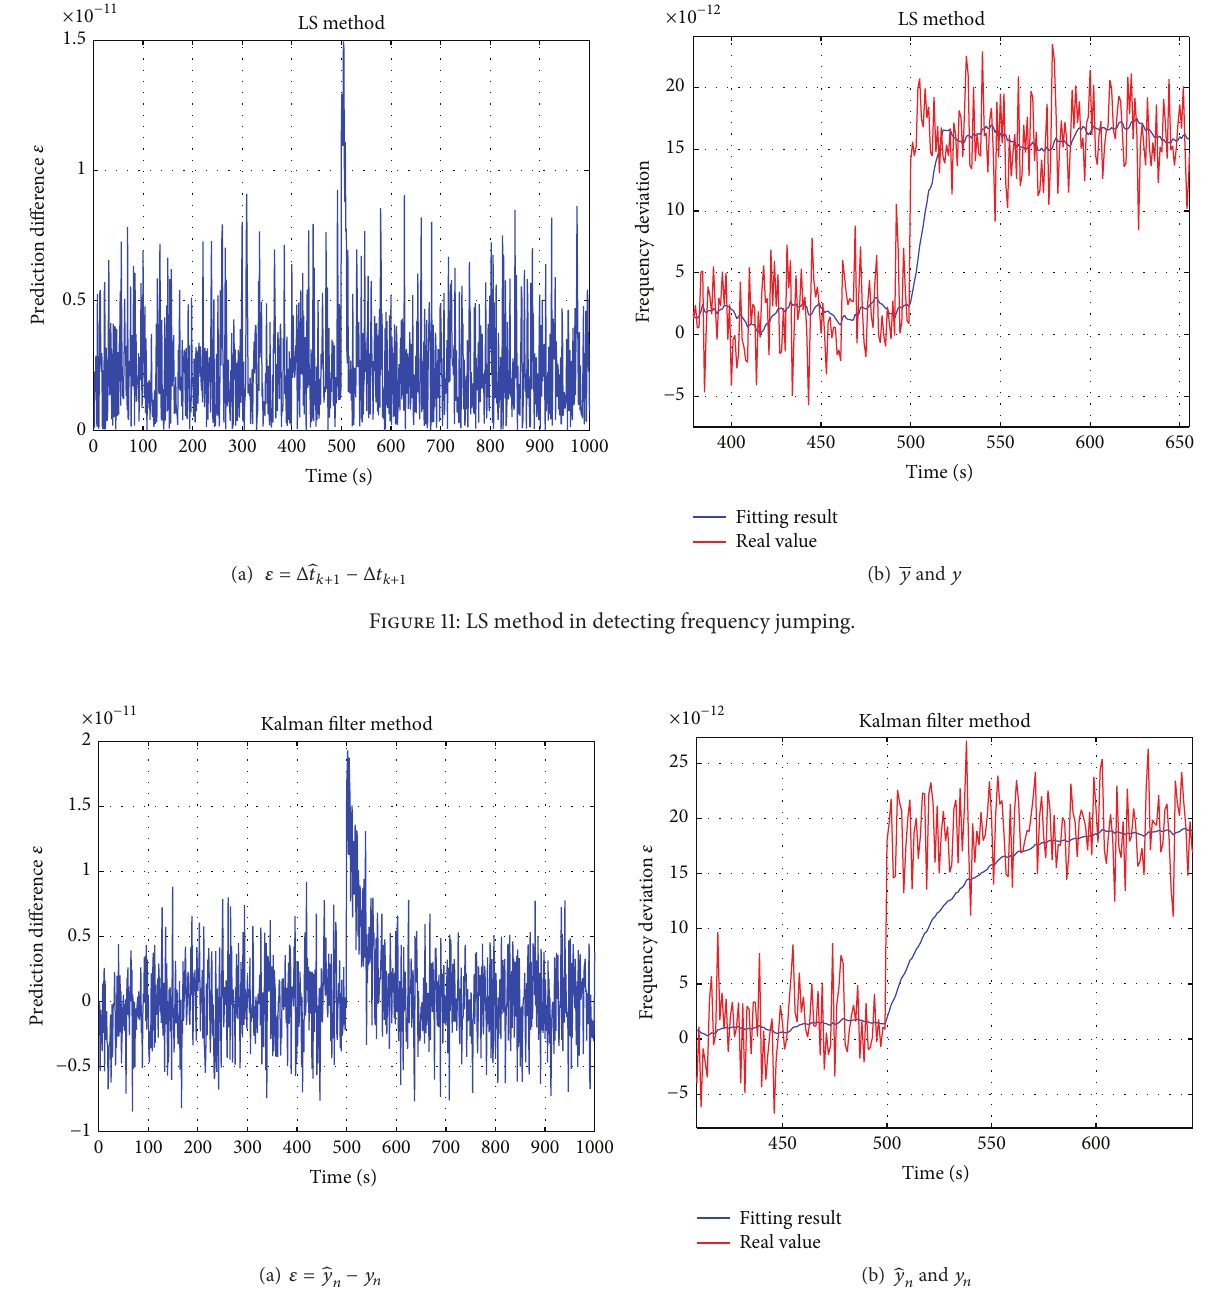
Figure 12: Kalman filter method in detecting frequency jumping.